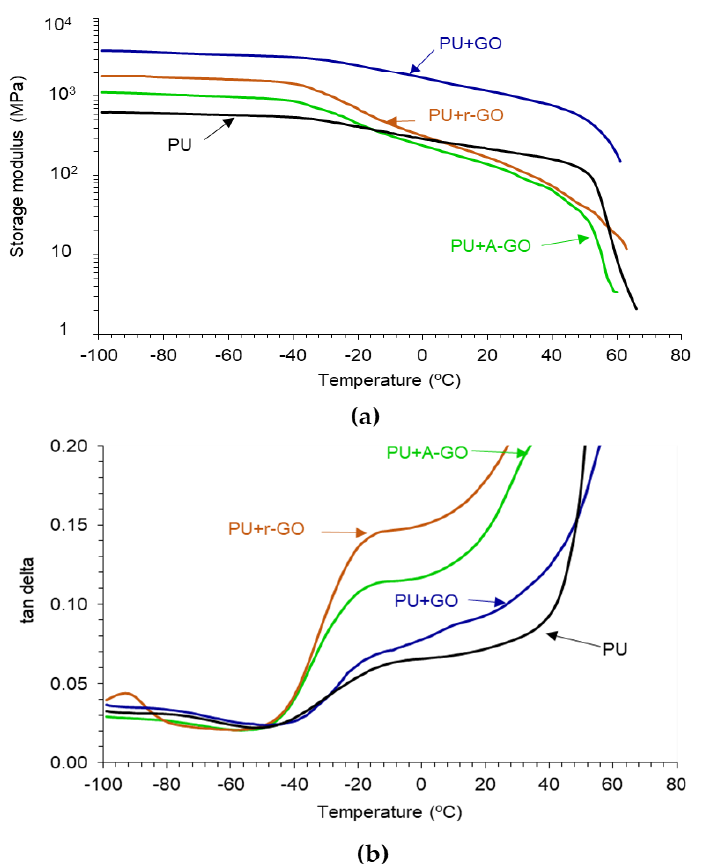
Figure 14. ( a ) Variation of the storage modulus (E′) as a function of the temperature for PUs; ( b ) Variation of tan delta as a function of the temperature for PUs. DMA experiments.